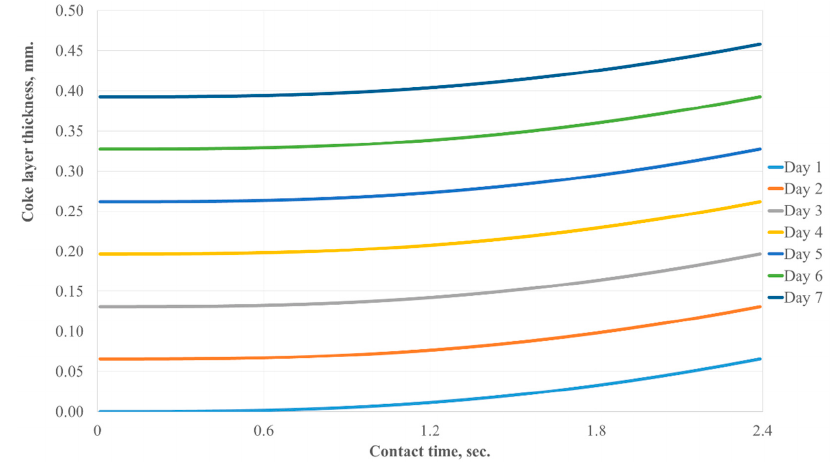
Figure 8. Change of the coke layer thickness with an increased contact time.